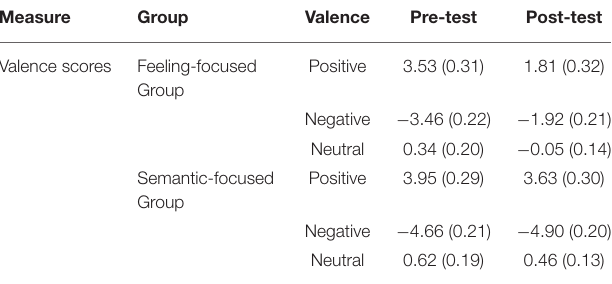
TABLE 2 | Means (standard deviations) of valence scores between pre-test and post-test for three valence categories in two